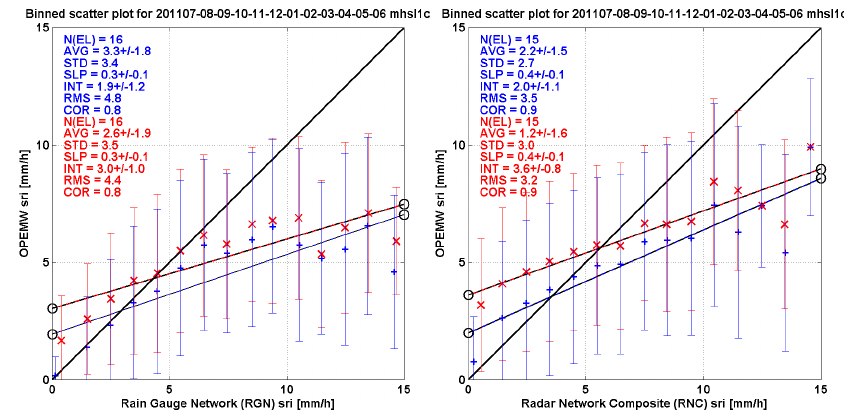
Fig. 7. Scatter plot of binned analysis for the 1yr period under analysis (July 2011–June 2012). The y axes report the OPEMW sri product, while the x axes report RGN sri (left) and RNC sri (right) products. Blue markers indicate results using all data, while red crosses indicate results considering hits only. The following main statistics are shown: the number of available bins (N), the mean (AVG), standard deviation (STD), and root-mean-squared (RMS) difference, the correlation coefficient (COR), and the slope (SLP) and intercept (INT) for a linear fit. Numbers after the + / − sign indicate the 95% confidence interval. Error bars indicate one STD of OPEMW sri values within each bin.